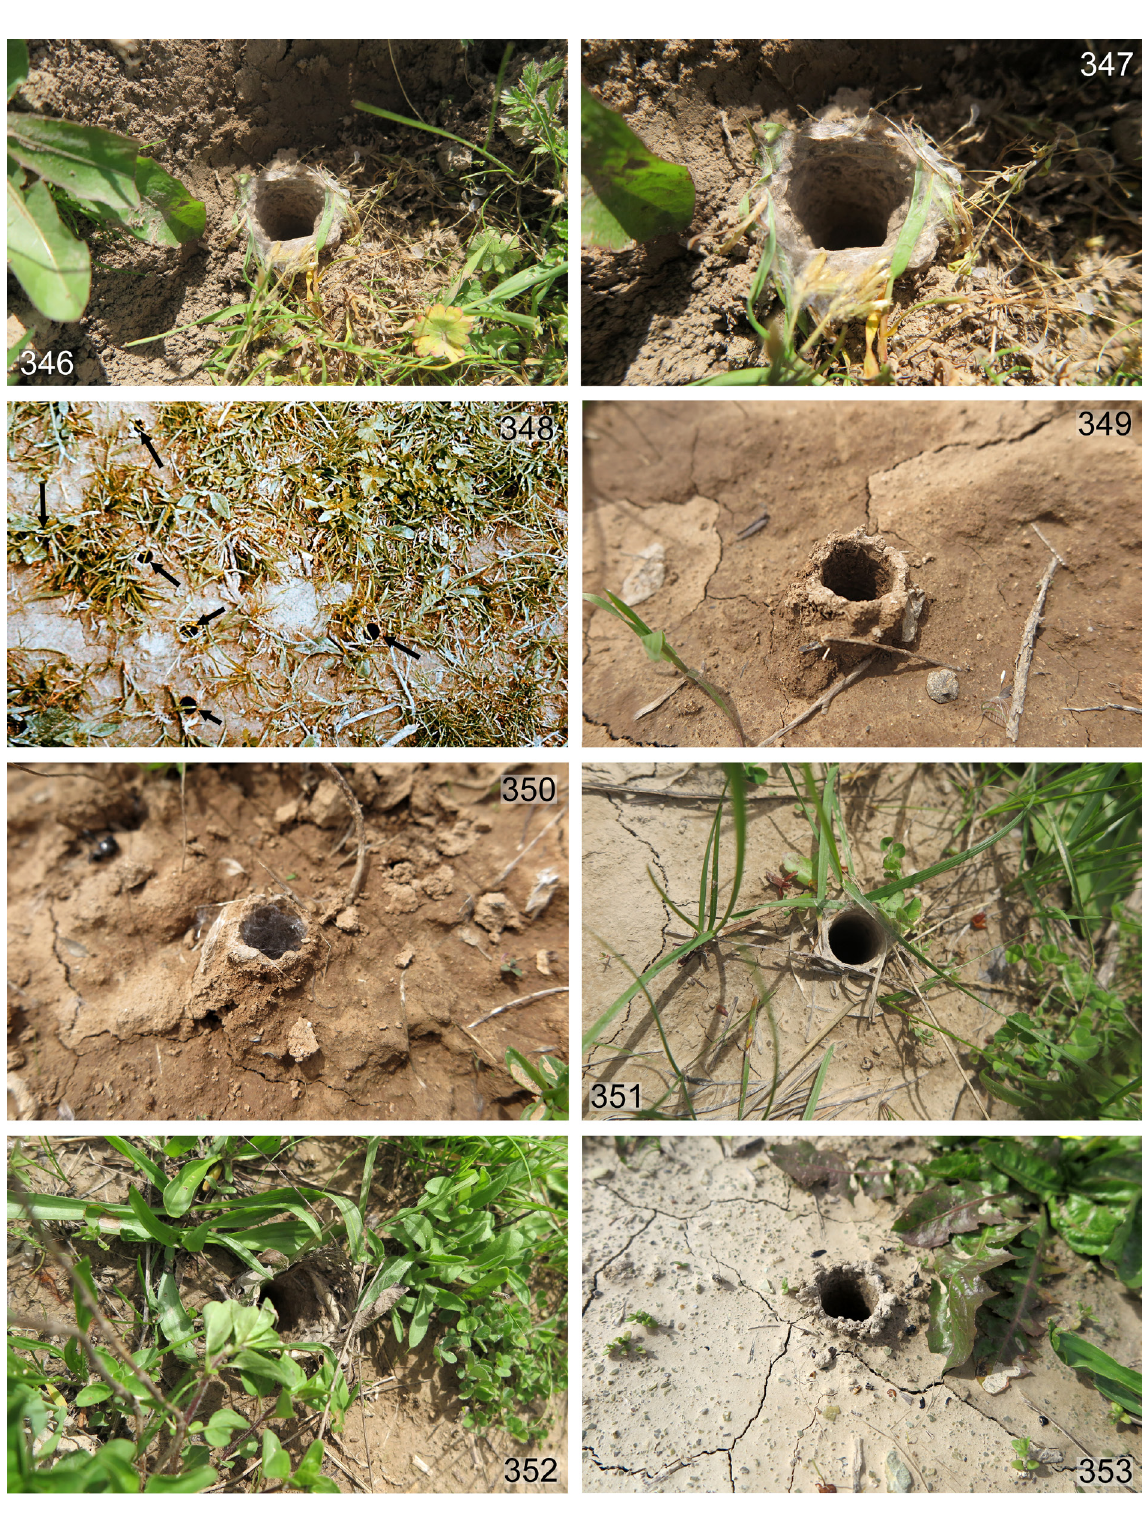
Figs 346–353. Anemesia infuscata sp. nov., burrow entrances: opened (346–349, 351–353), aggregated (348), curtained with web (350), located on escarp (352) and different substrates; Tajikistan. 346– 347 . Varzob Canyon. 348–353 . Sanglok Mts. Black arrows indicate